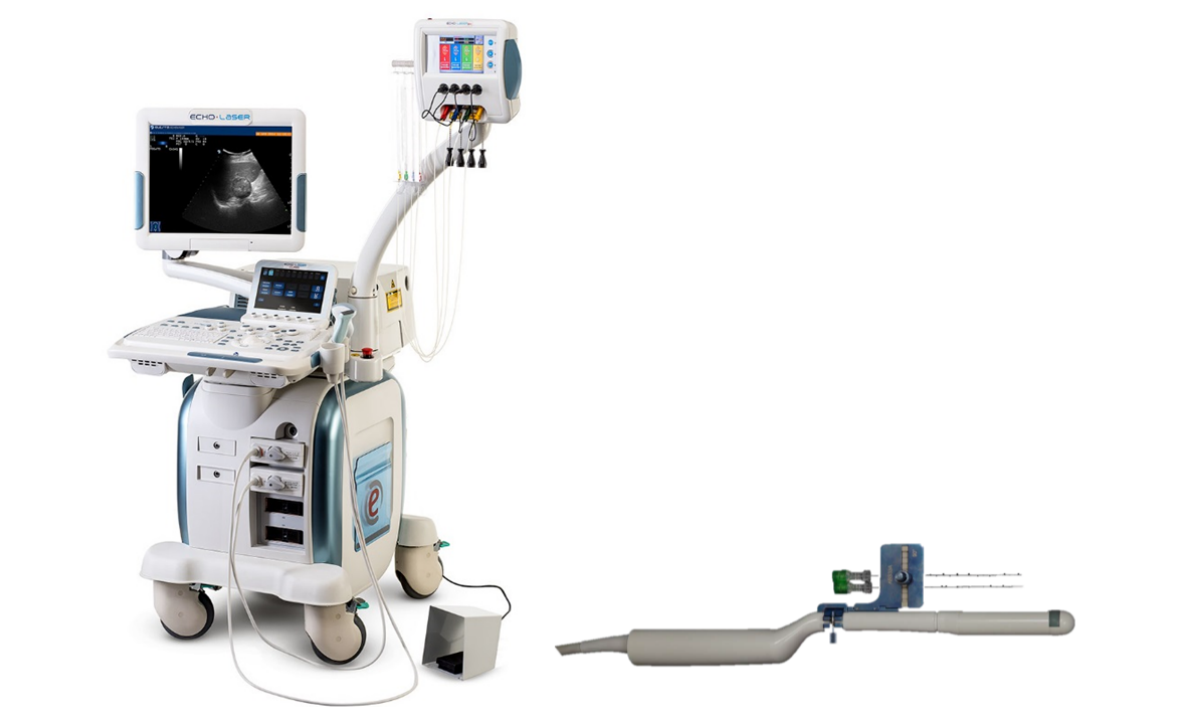
Figure 2. The EchoLaser system with 4 fibers combined with the MyLab Eight eXP ultrasound device from Esaote (left) and the TRT33 probe with needle guide system (right).